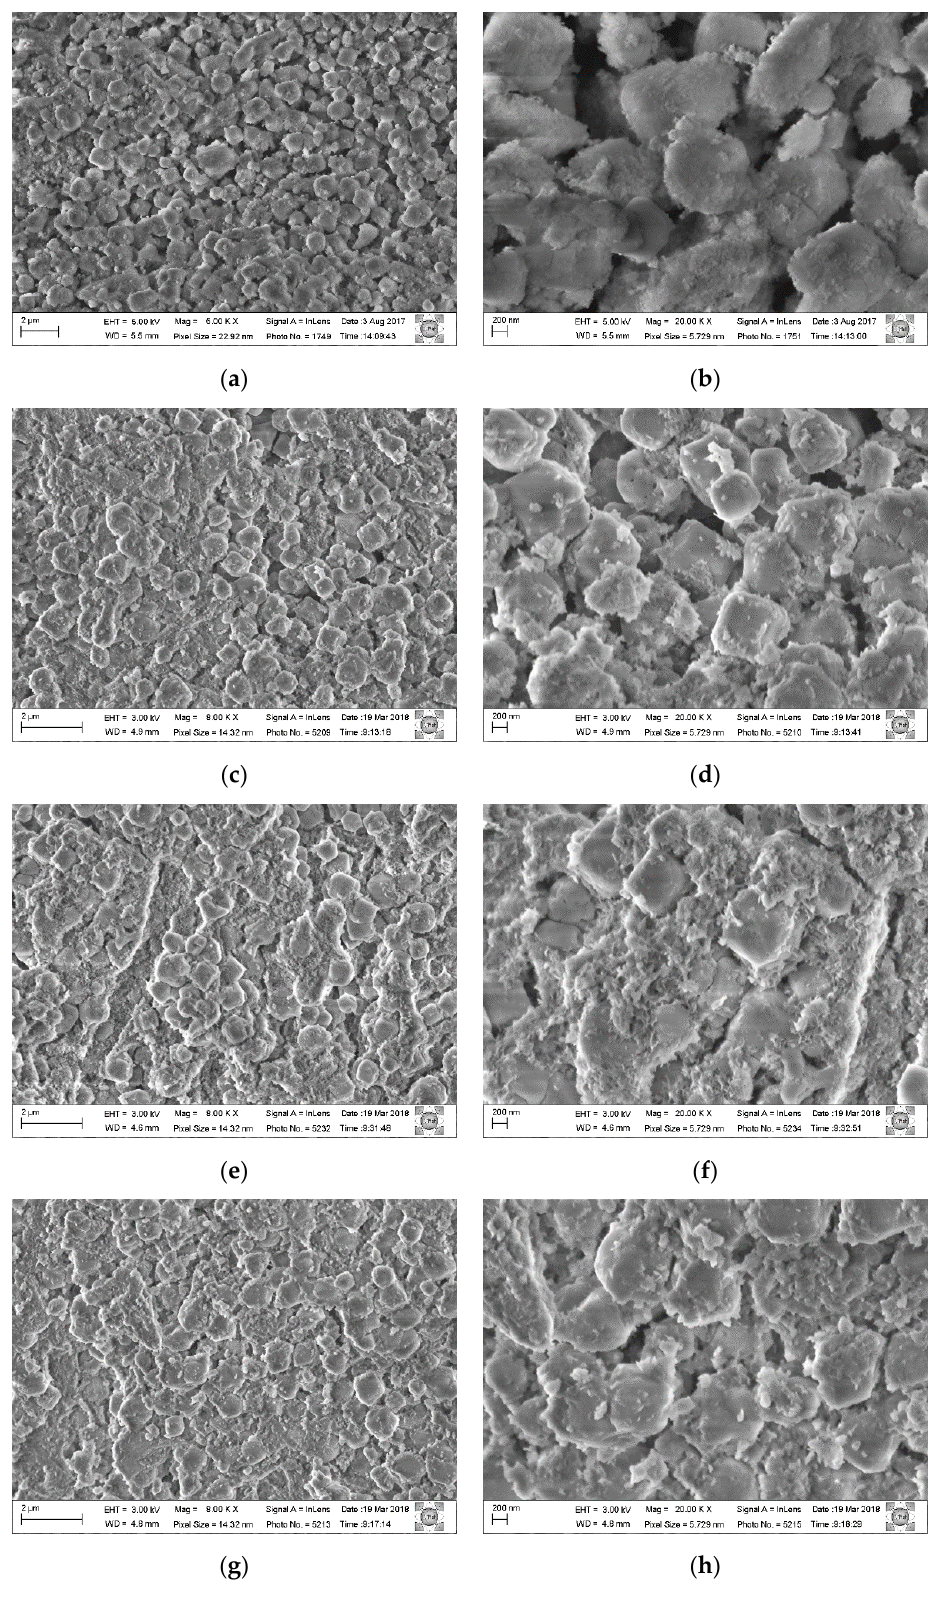
Figure 7. Micrographs of the composite Al,Mg-LDH/ZA, before and after calcination and rehydration processes: ( a , b )as-synthesized composite Al,Mg-LDH/ZA; ( c , d ) composite calcined at 300 ◦ C under the flow of He and rehydrated; ( e , f ) composite calcined at 300 ◦ C under the flow of O 2 and rehydrated; ( g , h ) composite calcined at 500 ◦ C under the flow of O 2 and